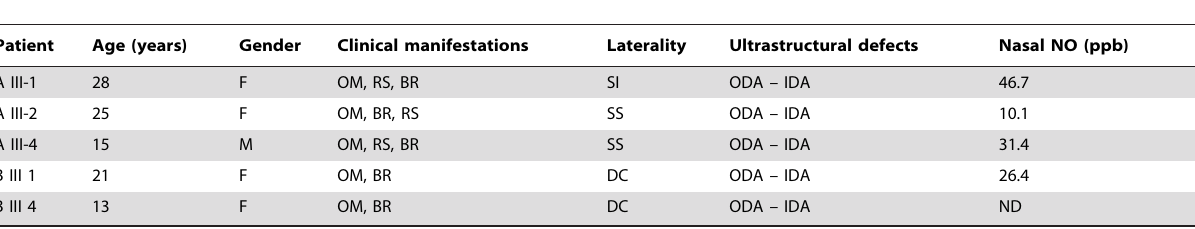
Abbreviations: BR, bronchiectasis; DC: dextrocardia; OM, chronic or recurrent otitis media; RS, rhinosinusitis; SI, situs inversus totalis ; SS, situs solitus ; ODA, outer dynein arm; IDA, inner dynein arm; ND, not